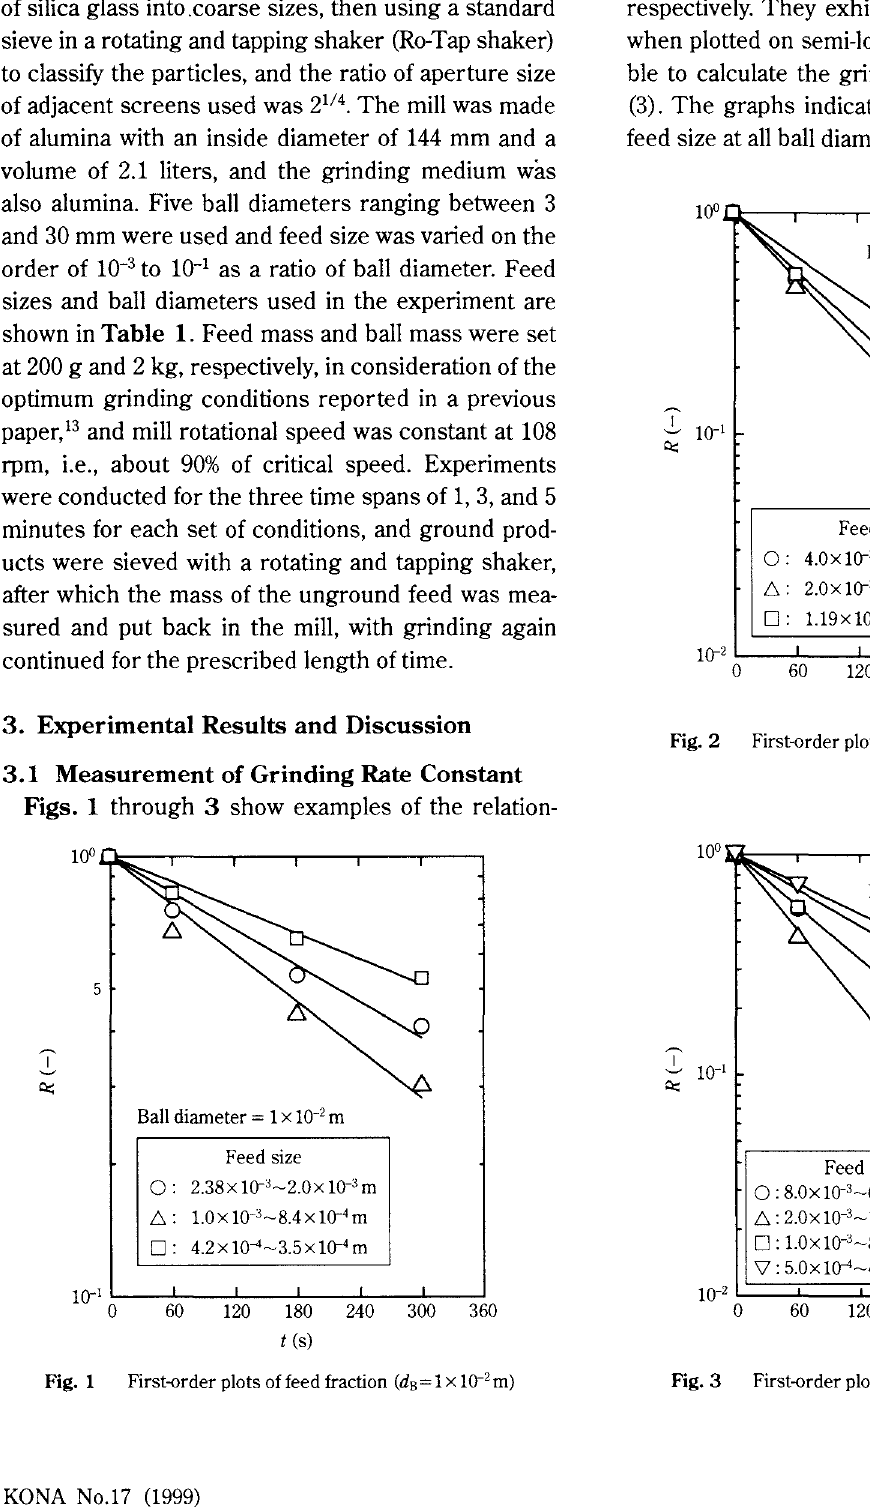
Feed size 0: 8.0x1o-3-6.7x1o-3m